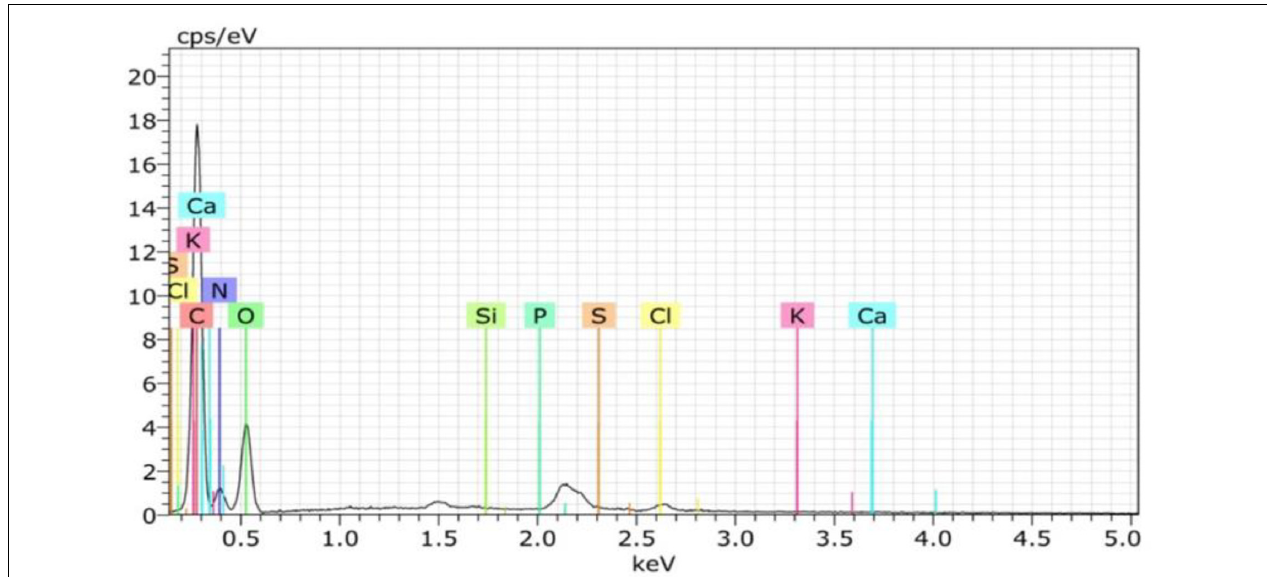
FIGURE 2 | Element compositions (EDX) of horseshoe crab ( Carcinoscorpius rotundicauda ) shells.